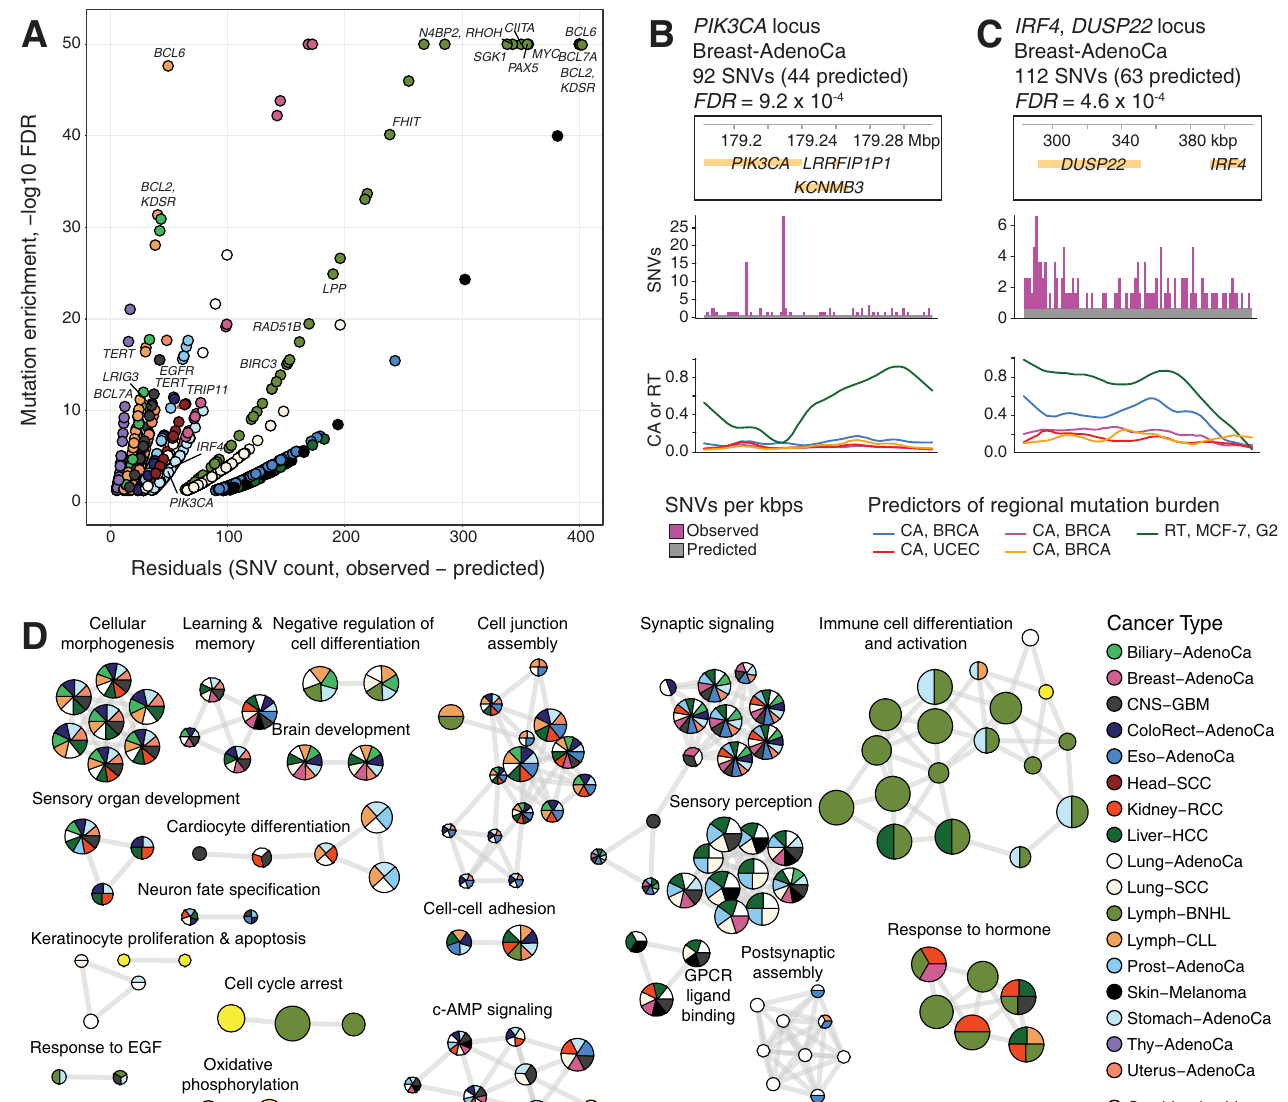
Fig 5. Genomic regions with overrepresented mutations converge to cancer genes and developmental pathways. A. Genomic regions (100-kbps) with overrepresented mutations that significantly exceeded the predictions of models informed by CA and RT profiles. Regions with significantly higher model residuals are shown ( FDR < 0.05). Significant regions with known cancer genes are labeled ( FDR < 10 − 10 ). Colors indicate the cancer types where the overrepresented mutations were found (see panel D). X-axis is capped at 50 and Y-axis is capped at 400. B-C . Examples of genomic regions with overrepresented mutations and known or putative cancer driver mutations. The plots show the genes in the region (top), observed and expected mutation burden (SNVs per kbps; middle), and the top five most significant predictors in our models ( i . e ., CA and RT profiles; bottom). B. The genomic region encoding the driver gene PIK3CA in breast cancer. C. Super-enhancer region at the IRF4 - DUSP22 locus with overrepresented mutations in breast cancer. D. Pathway enrichment analysis of the genomic regions where the mutations were overrepresented compared to CA- and RT-informed predictions. The enrichment map visualisation shows significantly enriched biological processes and pathways ( FDR < 0.05). Nodes in the network represent enriched pathways and processes, the edges connect nodes sharing many genes, and the manually annotated sub-networks represent functionally related pathways and processes. Colors show the cancer types where the pathway enrichments were detected. The pathways and processes that were only detected in the joint analysis of multiple cancer types are shown in yellow.